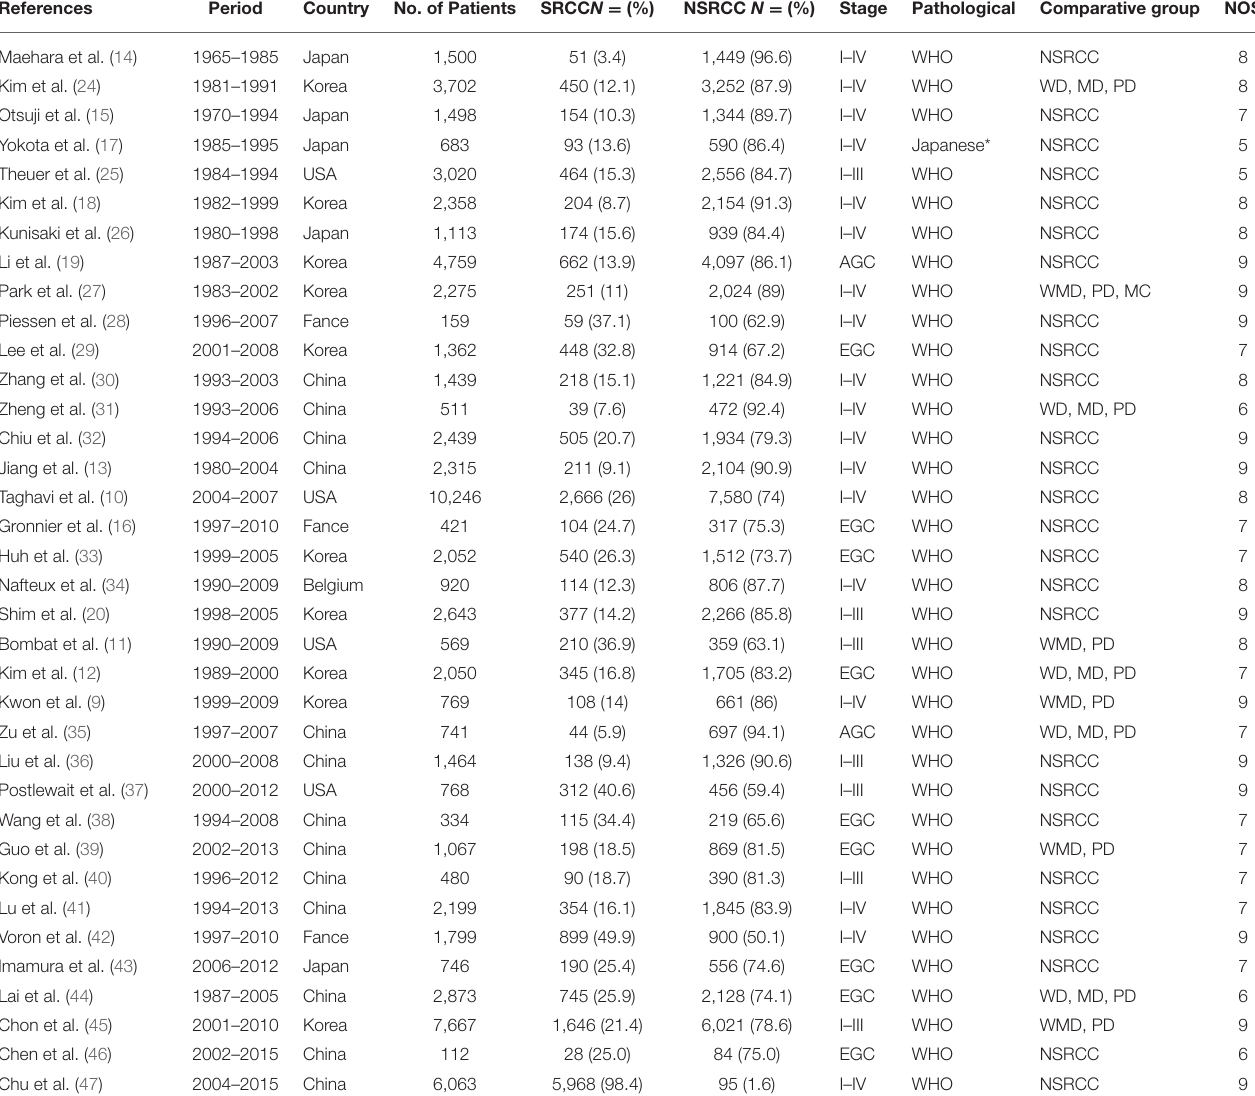
TABLE 1 | Characteristics of the included